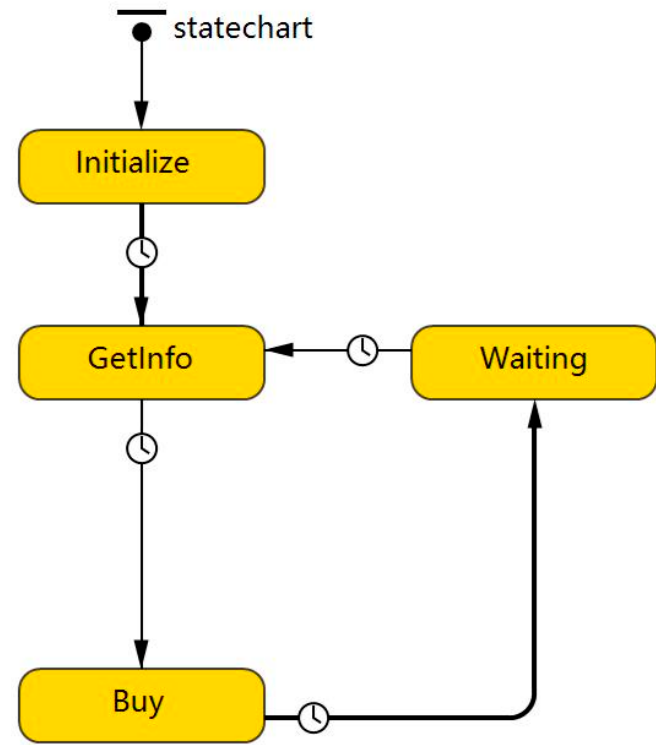
Figure 4. Consumers’ statechart.